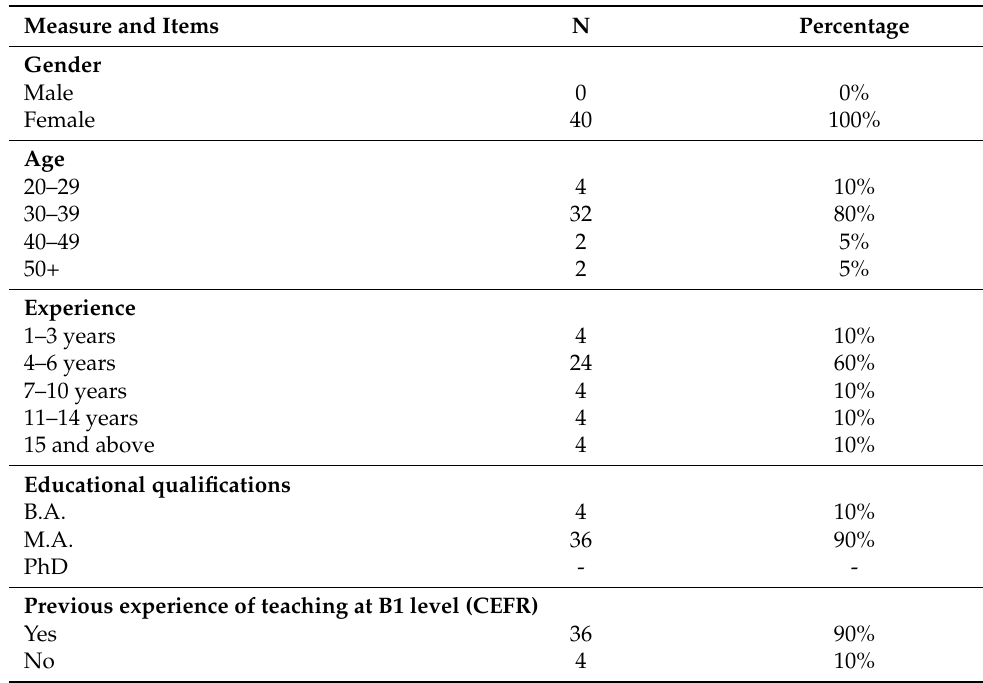
Table 1. Characteristics of the participating teachers (N =